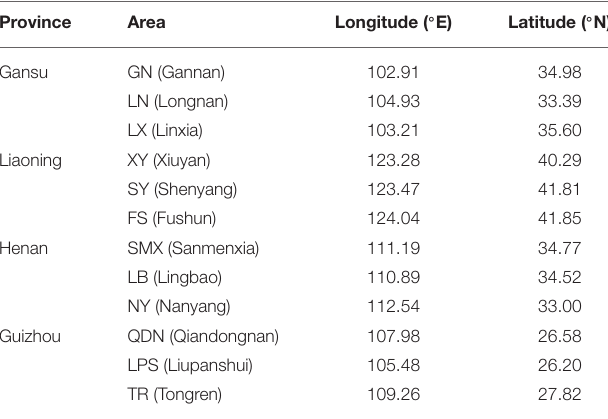
TABLE 1 | The detailed information of Morchella sp.